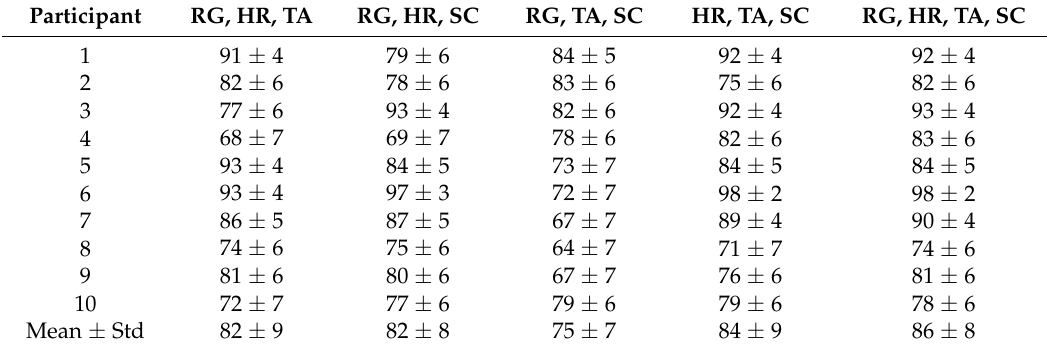
Table 4. Probability of successful detection of stress level using three or all the stress markers as features.